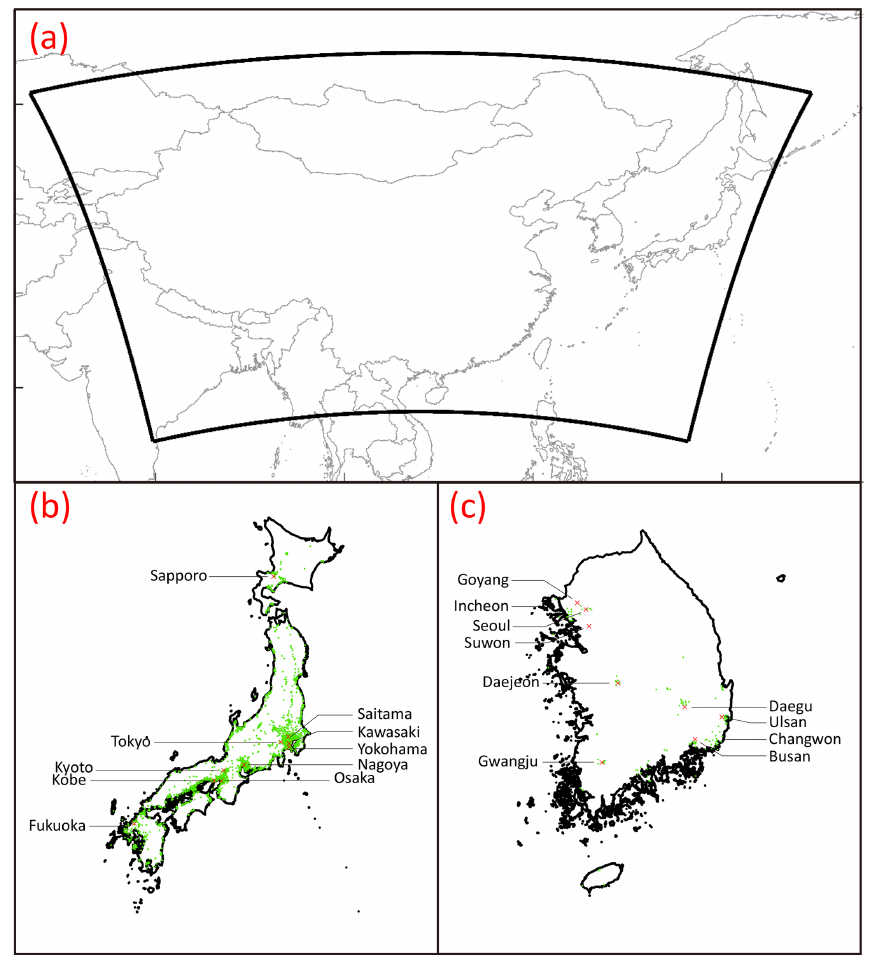
Figure 1. (a) Model simulation domain (solid black line). Monitoring stations (green dots) and major cities (red crosses) with populations ≥ 1 million in (b) Japan and (c) South